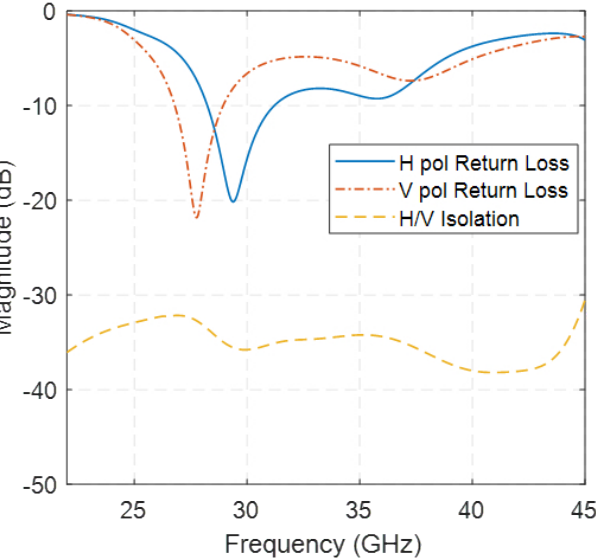
Figure 3. H and V polarization return loss and H/V isolation after first step of optimization.